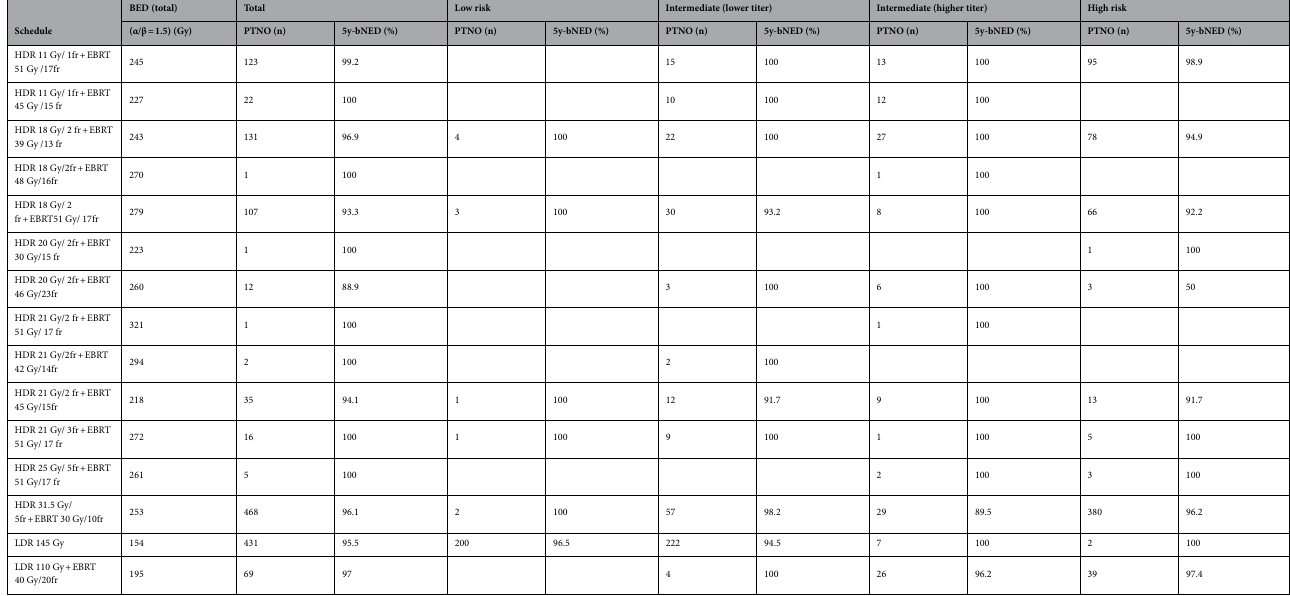
Table 4. The 5-year biochemical control rates according to biological equivalent dose (BED). bNED biochemical control rate, BED = biological equivalent dose = nd(1 + d/[α/β]) : n = Number of treatment fractions : d = Dose per fraction in Gy.